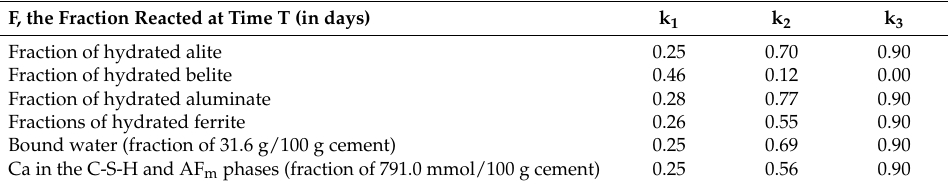
Table 7. Constant values assumed in the empirical Equation (5), where F is the fraction that is reacted at time T (in days) [19].